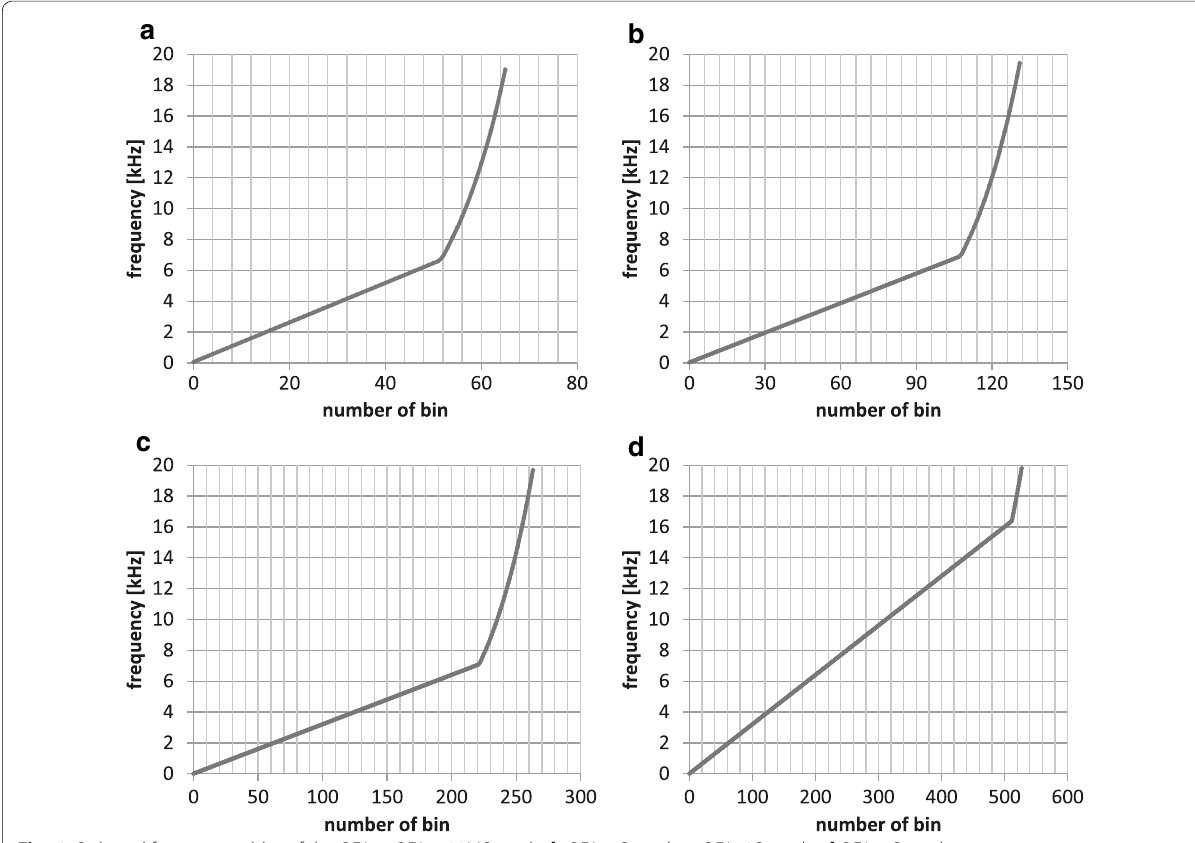
Fig. 6 Onboard frequency tables of the OFA. a OFA_500MS mode, b OFA_1S mode, c OFA_2S mode, d OFA_4S